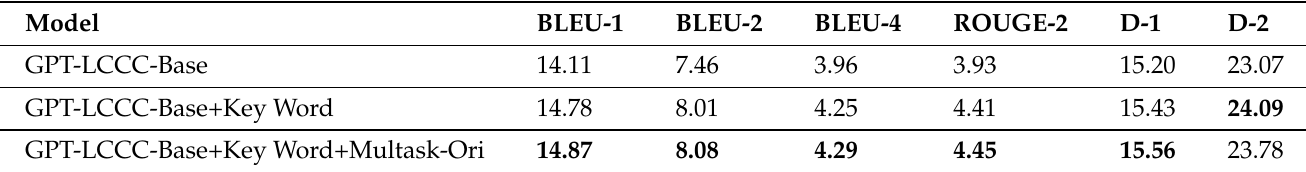
Table 6. Results on Clean STC. For each evaluation metric in every column, the best result is highlighted in